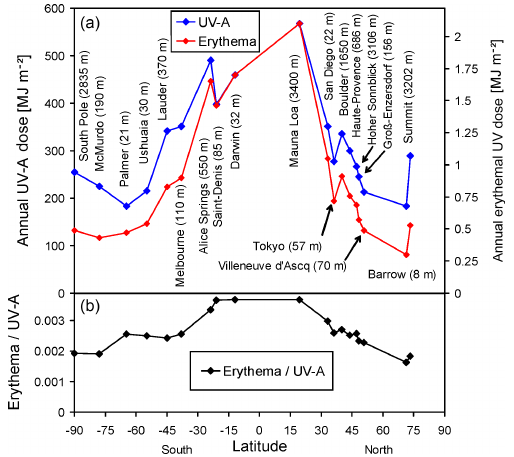
Figure 14. Application of a chemical-transport model (GMI) to in- terpolation of NDACC data from a polar station (Kiruna; 68 ◦ N, 20 ◦ E). Panel (a) shows 255 FTIR HNO 3 measurements. Panel (b) shows how the model with MERRA analyses estimates the impact of sampling bias due to missing winter